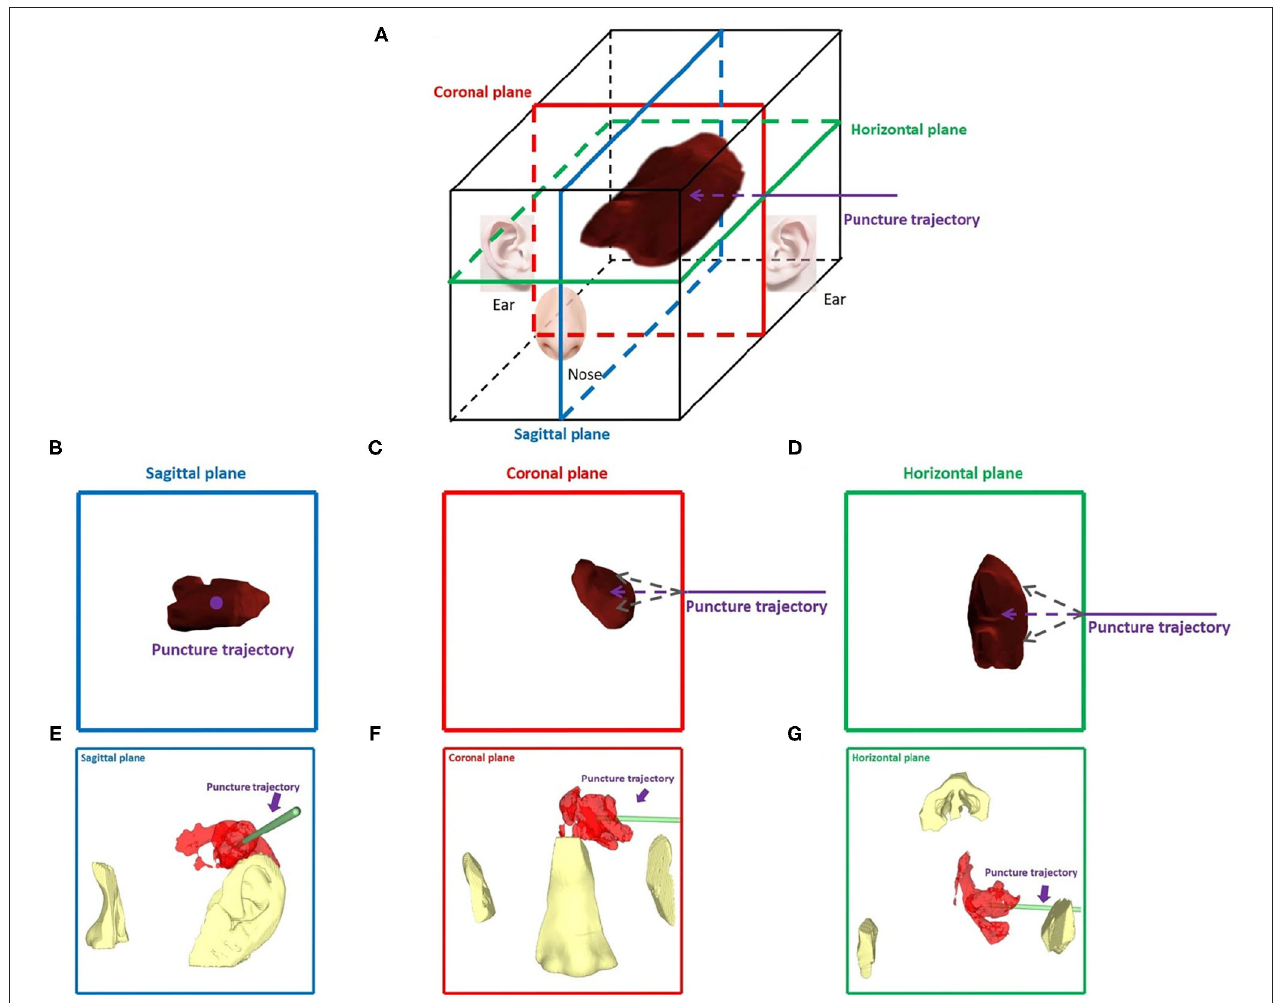
FIGURE 1 | Dual-plane navigation puncture. (A) The head was considered a six-sided cube with horizontal, sagittal, and coronal planes. According to the hematoma puncture trajectory designed before surgery, the puncture angle and depth were observed from two planes. (B–G) For example, a hematoma was punctured at the basal ganglia from the temporal region, and hematoma and puncture trajectories were observed in the sagittal, coronal, and horizontal planes, respectively. (B–D) Theoretical images of different planes. (E–G) Wearing HoloLens, images of the different planes were presented by adjusting the locations of the nose and